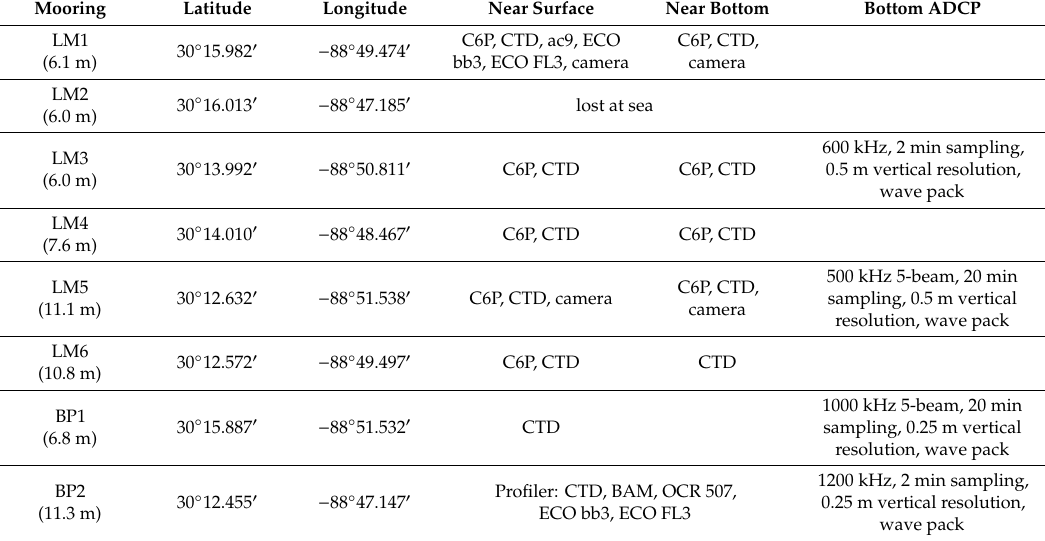
Table 1. Mooring locations and instrumentation. Water depths at mooring location are indicated in parentheses. BP2 was a profiling mooring (thus, no surface or bottom instrument nodes), the others were line moorings. See text for further clarifications and parameters measured. CTD: Conductivity, Temperature, Depth; C6P: 6-channel fluorometer; ECO FL3: Environmental Characterization Optics 3-channel fluorometer; ECO bb3: 3-channel backscatter sensor; BAM: Beam Attenuation Meter; OCR 507: Ocean Color Radiometer,